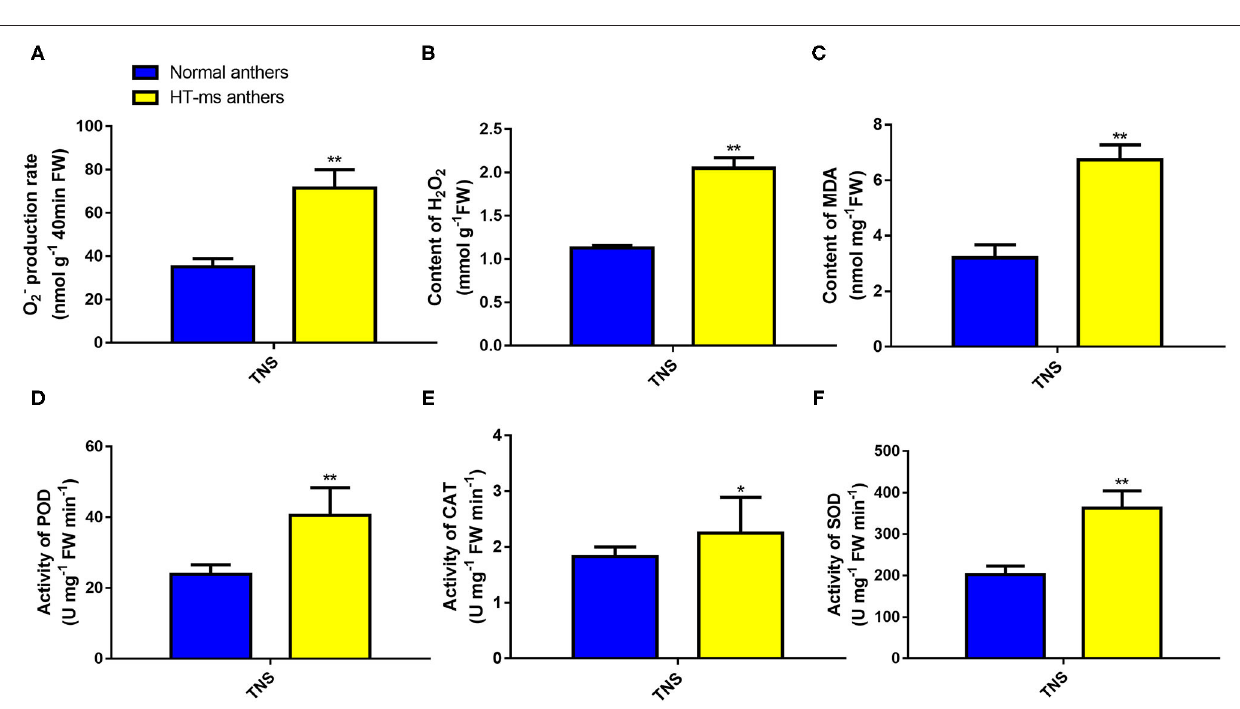
FIGURE 7 | Reactive oxygen species (ROS) accumulation and POD, CAT, and SOD enzymatic activities in Normal and HT-ms anthers. The superoxide anion (A) , hydrogen peroxide (B) , and membrane lipid peroxidation (MDA) content (C) in Normal anthers and HT-ms anthers were measured at the trinuclear stage of development. The enzymatic actives of peroxidase (D) , catalase (E) , and superoxide dismutase (F) in Normal anthers and HT-ms anthers were also measured at the trinuclear stage. A single sample was used for three independent replicates ( n = 3). *, ** = Significantly different from the Normal anthers control at p < 0.05 and p < 0.01,